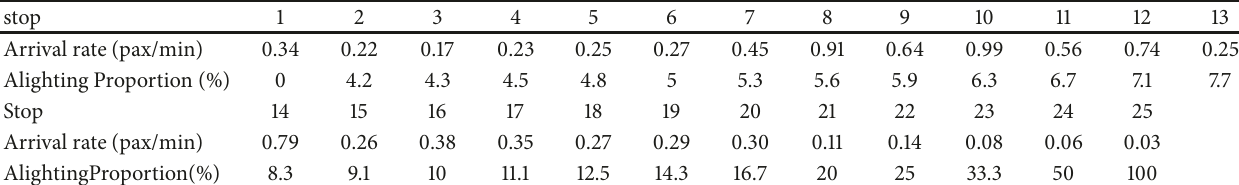
Table 1: Observed passenger arrival flow and derived alighting proportion on 87 Route.